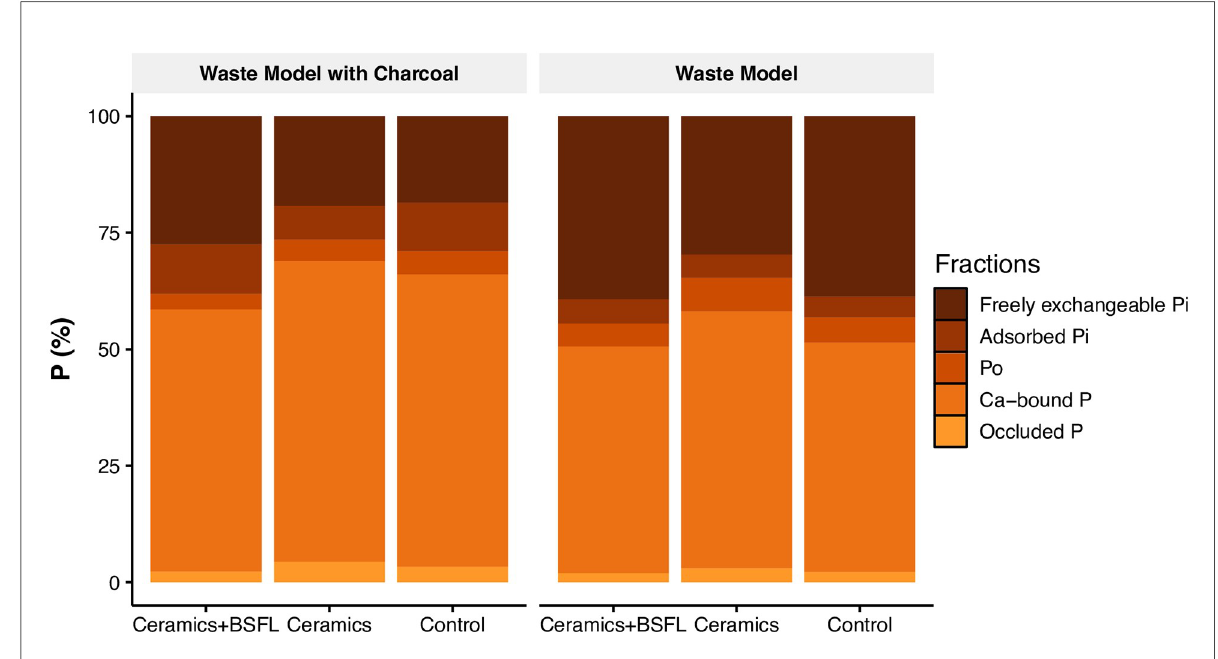
Fig 4. Relative distribution of the P fractions in the treatments with and without black soldier fly larvae (BSFL), ceramics, and for the waste models with (left) and without charcoal (right). Freely exchangeable inorganic P (Pi) = resin-Pi, adsorbed Pi = bicarbonate (0.5 M NaHCO3)-and sodium hydroxide (0.5 M NaOH)-extractable Pi, organic P (Po) = bicarbonate Po + hydroxide-Po, calcium-bound P = dilute acid-extractable (1 M HCl)-P, and occluded + residual P = concentrated-acid (97% HCl) extractable P and acid-digestible P (1:3 concentrated HNO 3 : concentrated HCl